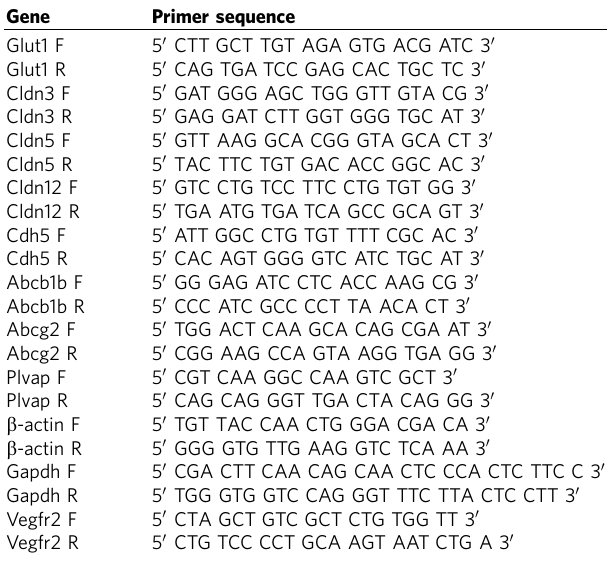
Table 1 | PCR primers utilized to examine levels of BBB signature genes or transcripts altered in Glut1